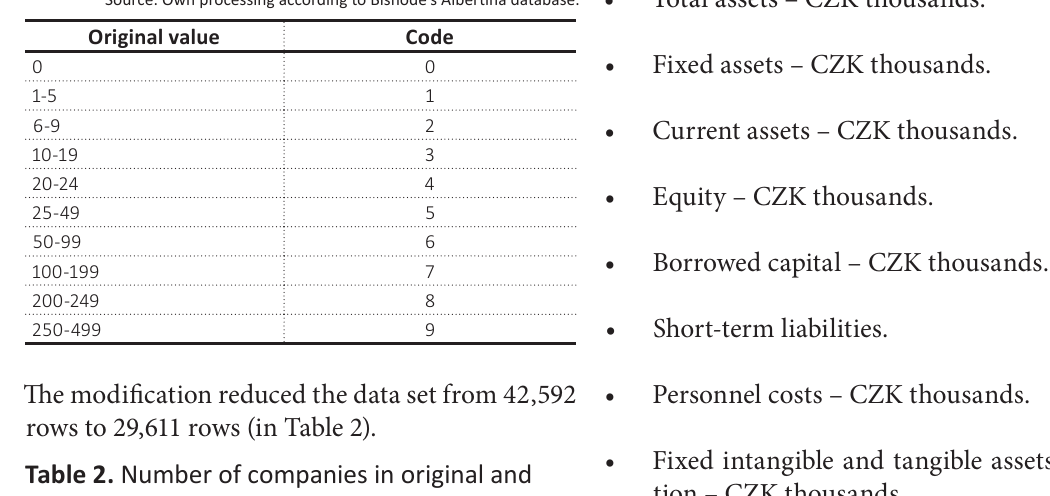
Table 2. Number of companies in original and modified data